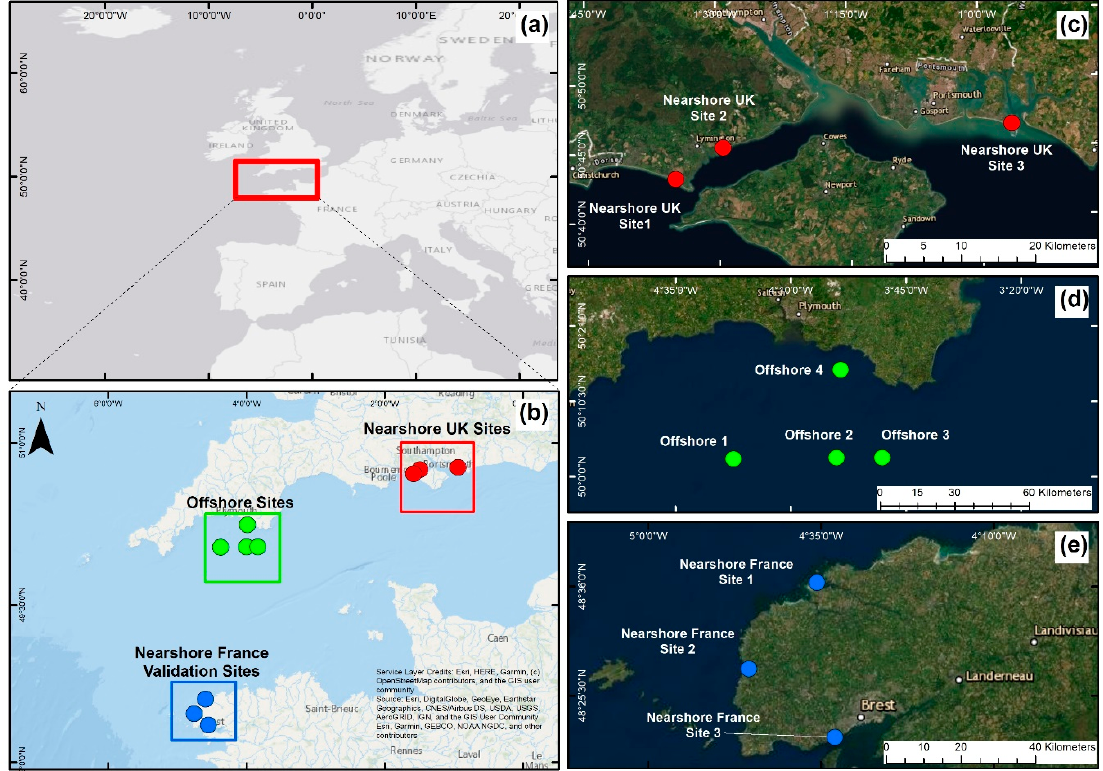
Figure 1. Geographical distribution of the sampling sites ( a ) Overview of the study area on the coasts of the English Channel, Europe. ( b ) The 3 main areas where datasets were collected in this study. ( c ) Three nearshore sites in the U.K. ( d ) Four offshore sites in the U.K. ( e ) Three nearshore sites in France, used as independent validation dataset for this study.